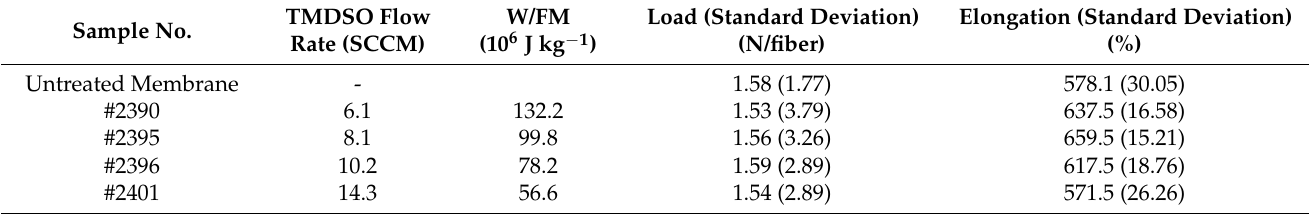
Table 6. Tensile properties of PP50/200 HFM before and after coating with F/Si Plasma polymer as a function of W/FM.